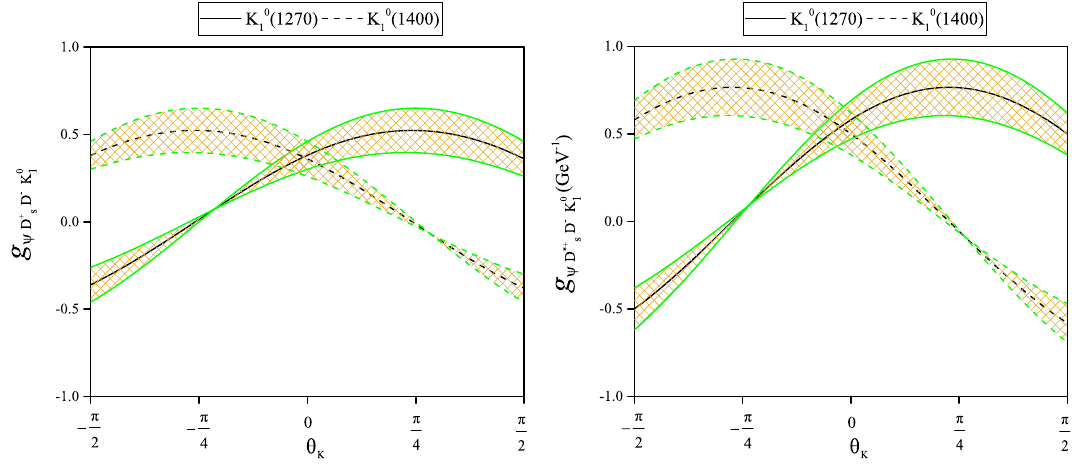
Fig. 6 The θ K dependence of the strong coupling constants g ψ